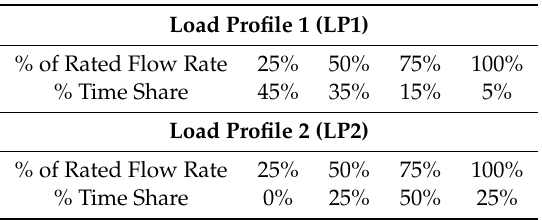
Table 3. Load profiles for typical pumping applications.